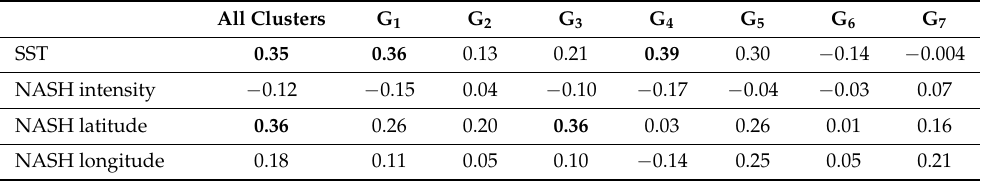
Table 1. Pearson’s correlation coefficients between annual time series of mean SST, the North Atlantic subtropical high-pressure system (NASH) intensity and NASH position (June to November) with the number of tropical cyclones (TCs) genesis in the whole NATL and each cluster. Statistical significance is marked with the bold text ( p < 0.05). NASH latitude and NASH longitude represent the NASH center latitude and NASH center longitude,